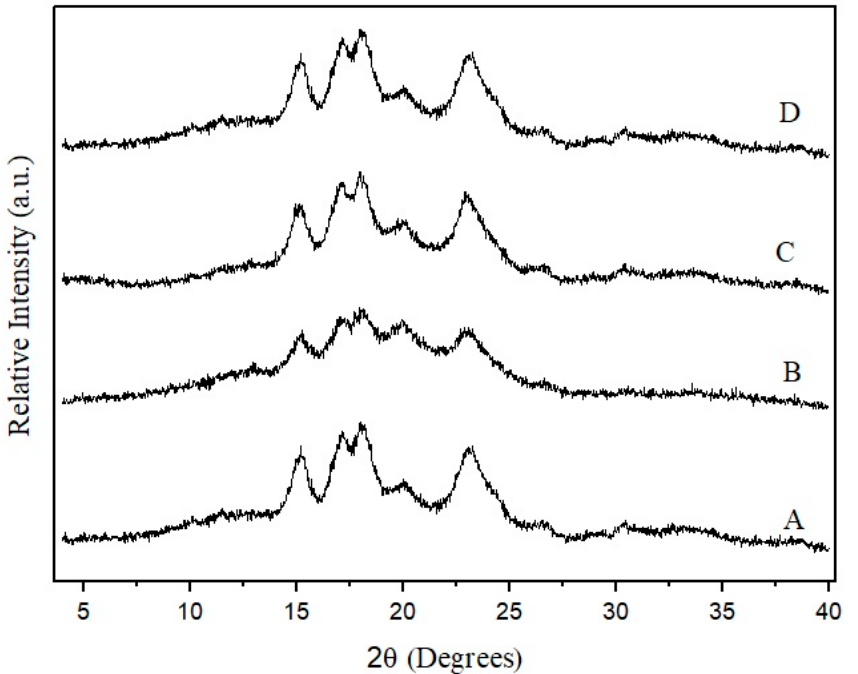
Figure 4. X-ray diffraction patterns of native and modified starches. ( A ) Native starch ( B ) HMT ( C ) Microwave ( D ) Sonication.